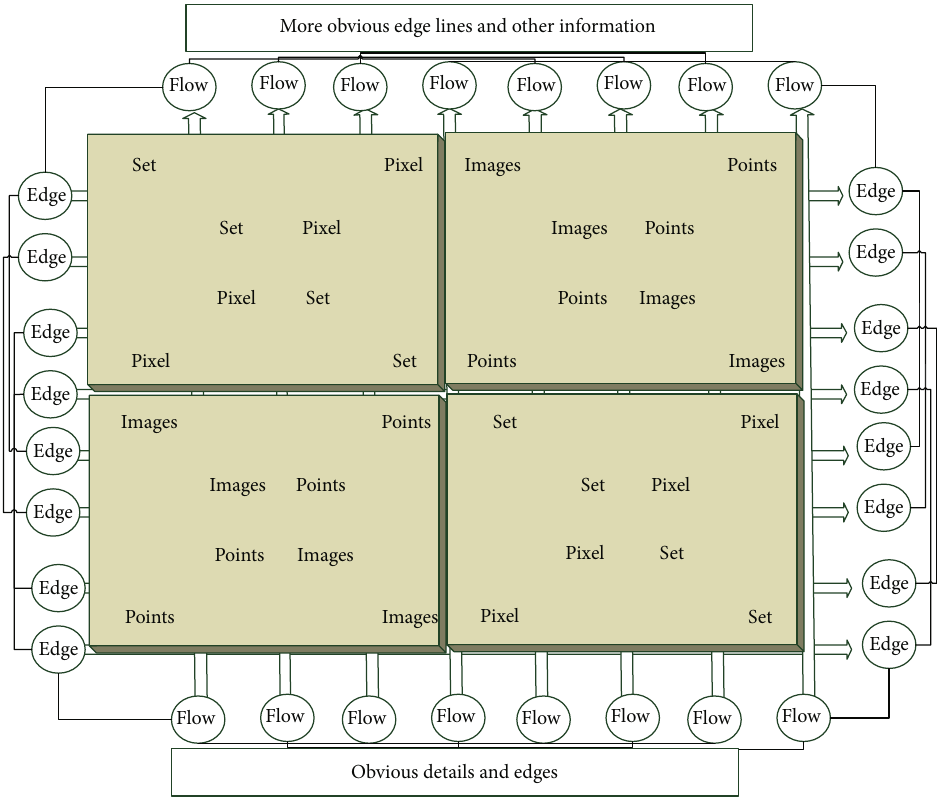
Figure 1: The spatial distribution of the solution set of the optical fl ow